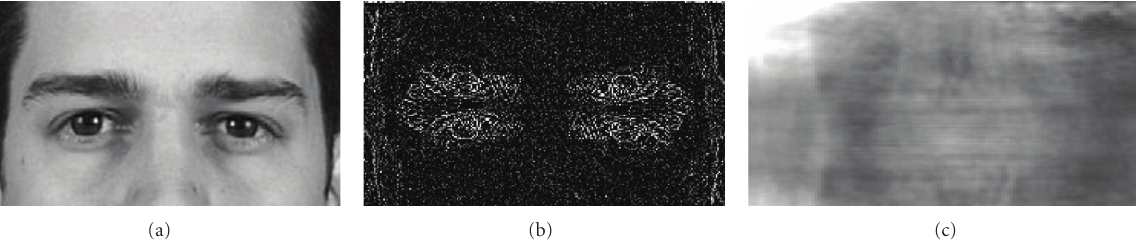
Figure 1: (a) The eye component, (b) and (c) the phase and the magnitude parts of the Fourier transform of the eyes.